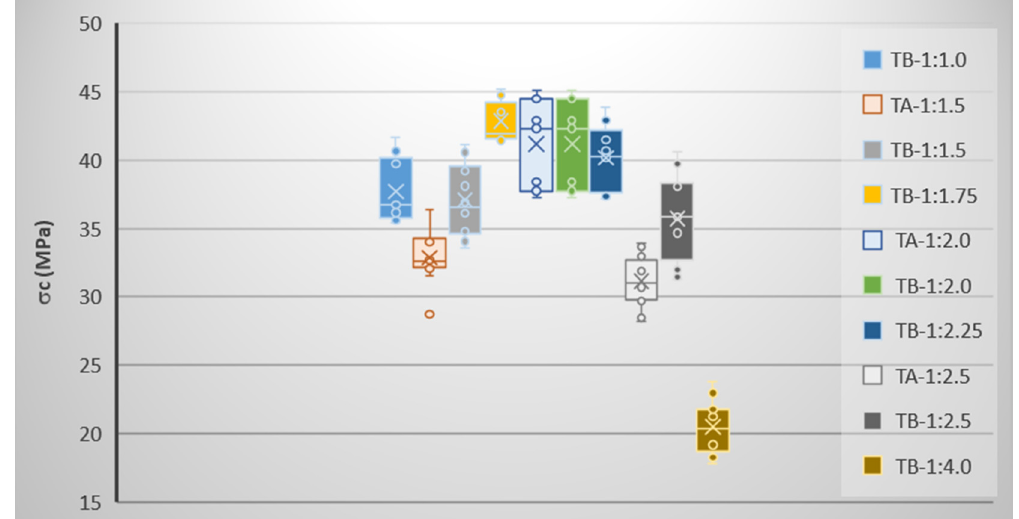
Figure 6. Statistical compressive strength for Type A and Type B mixes.